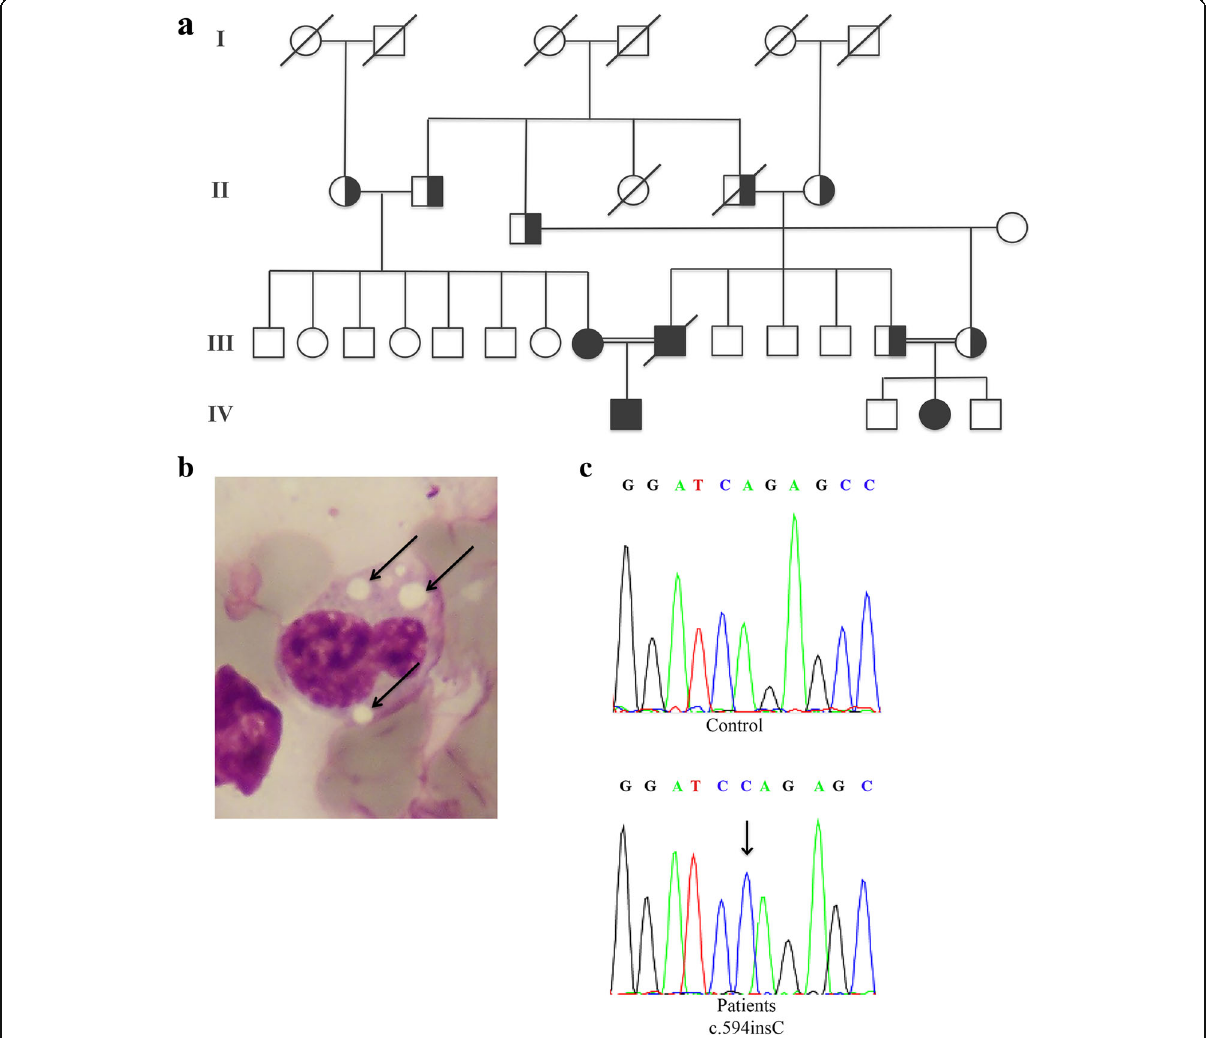
Fig. 1 Pedigree of CDS family ( a ). Microphotographs of May-Grünwald-Giemsa buffy coats of patient III-1 showing Jordan ’ s anomaly (arrows); original magnification 1000× ( b ). Sequence analysis showing the c594insC (N209X) ABHD5 mutation identified in homozygous status in all family members affected by CDS ( c